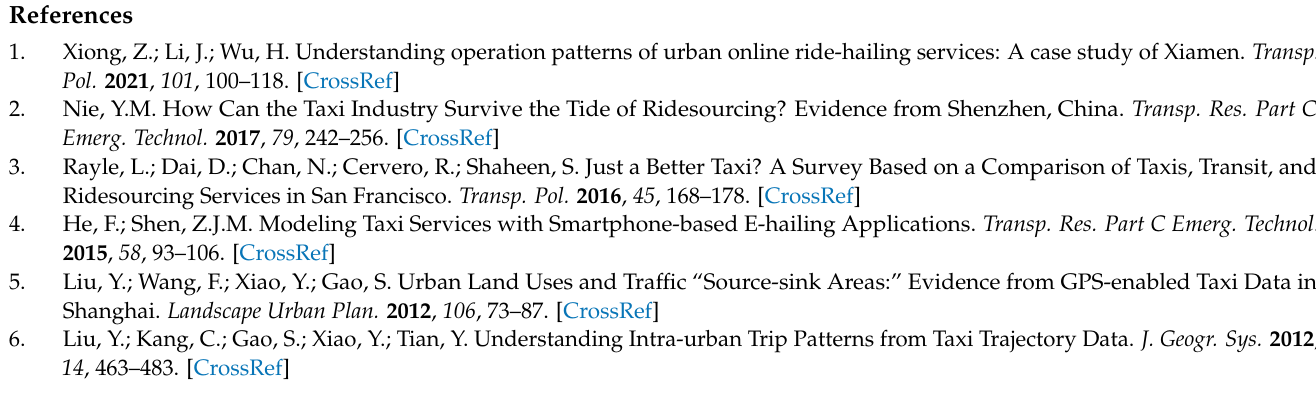
Figure A3. Pearson correlations between median trip distances by origin and destination: ( a ) taxiing on weekdays; ( b ) ride-hailing on weekdays; ( c ) taxiing on weekends; and ( d ) ride-hailing on